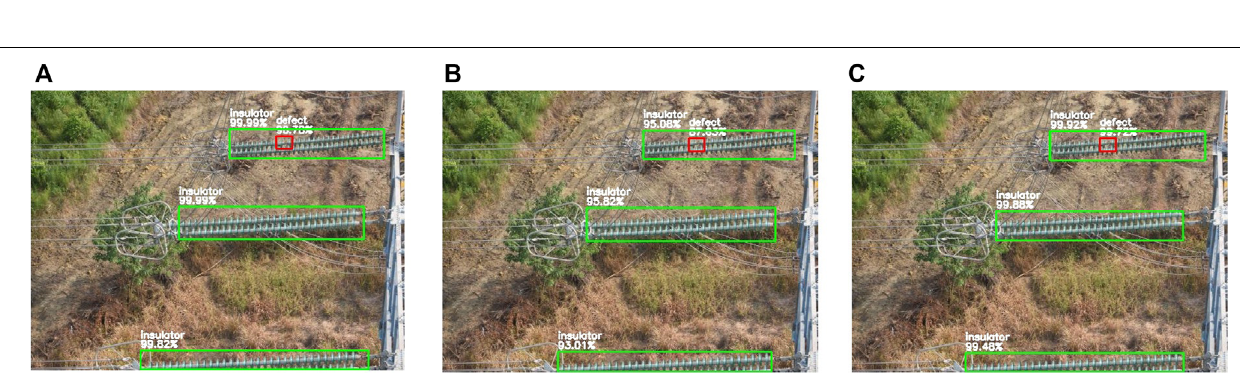
FIGURE 8 | Aerial image with earth in the background: (A) cascade R-CNN, (B) YOLOv5, and (C) DETR.